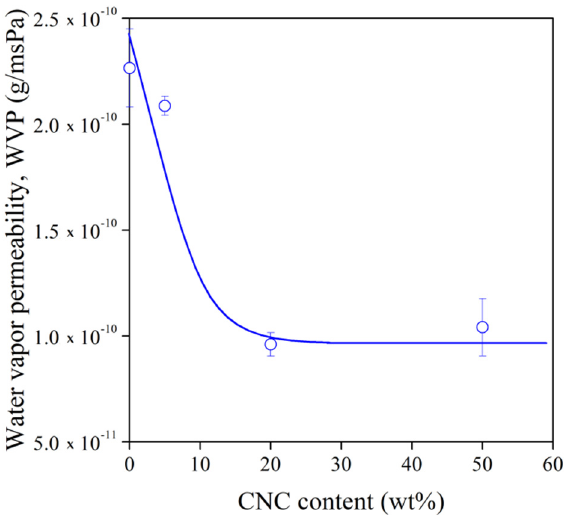
Figure 7. Water vapor permeability of TPS–CNC composites with 30% glycerol as a function of CNC content. Table 1. Comparison of water vapor barrier improvement in TPS–cellulose films.